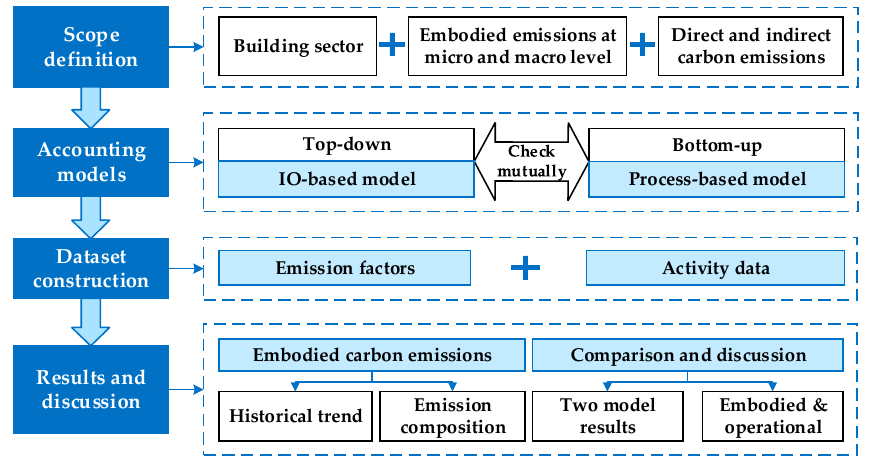
Figure 1. Research framework.